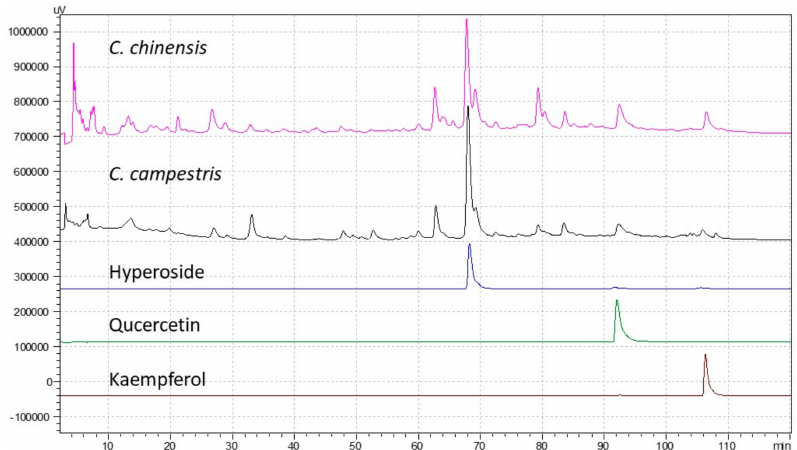
Figure 9. The HPLC profiles of C. chinensis and C. campestris . Phytochemical analyses of C. chinensis and C. campestris methanol extracts, as well as three standards, were performed using a Shimadzu HPLC system with an RP-18 column at UV 254